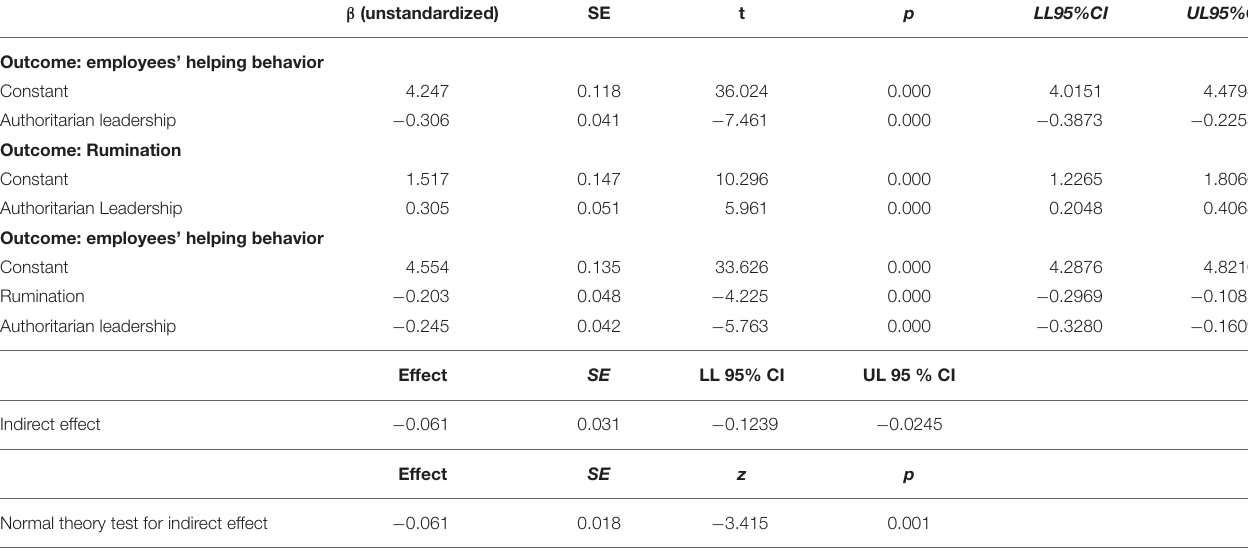
TABLE 3 | Mediation effect.